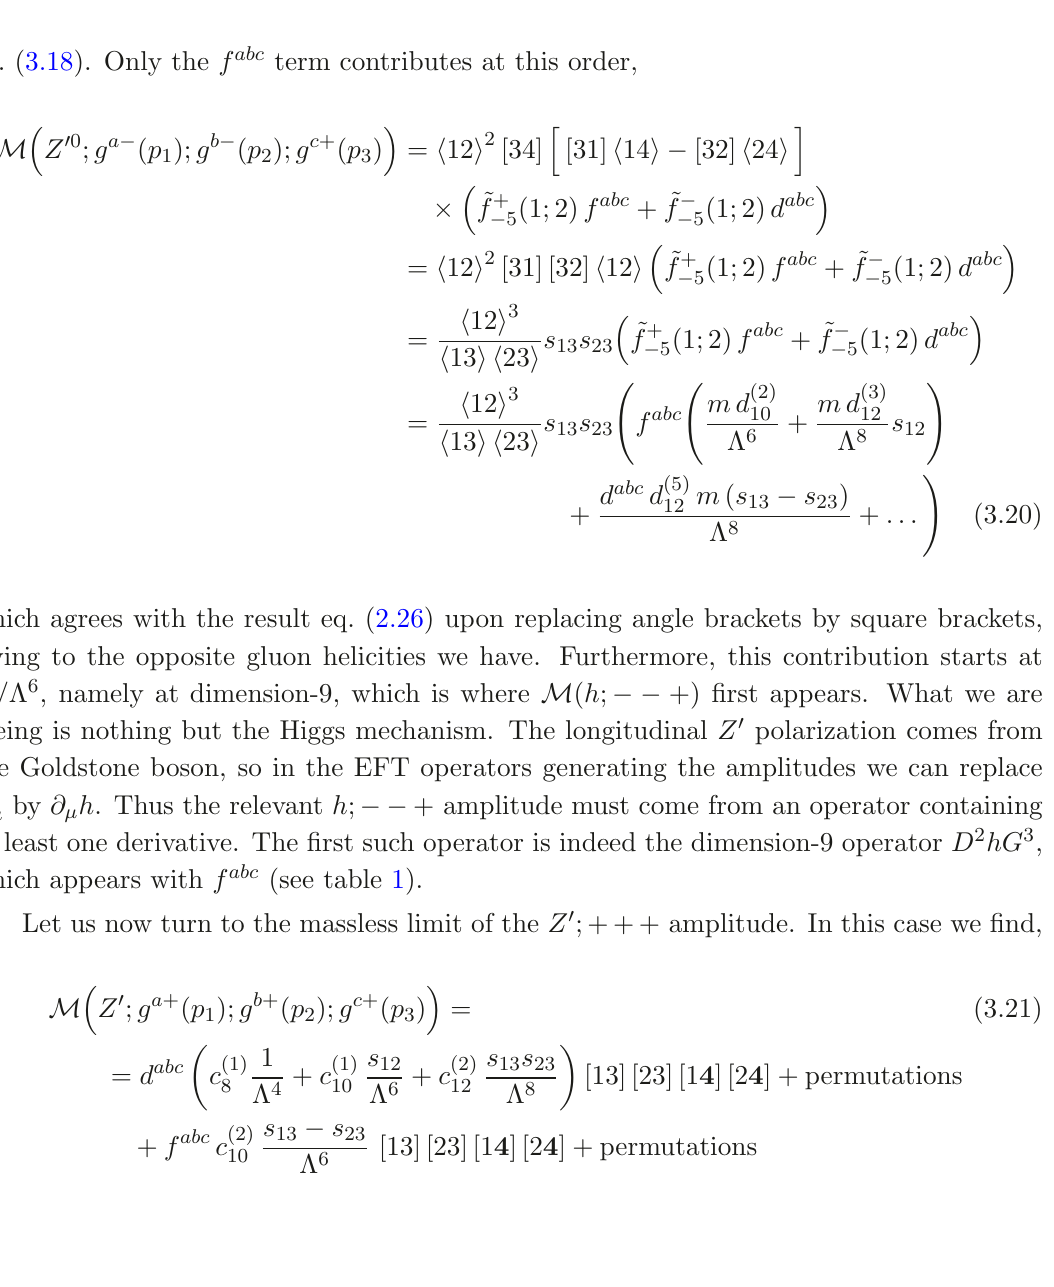
Table 3. Operators contributing to the Z ′ ggg amplitude for a massless Z ′ . The numbers of independent operators per each color structure are shown in brackets. (In the table, we use Z ′ to denote the field